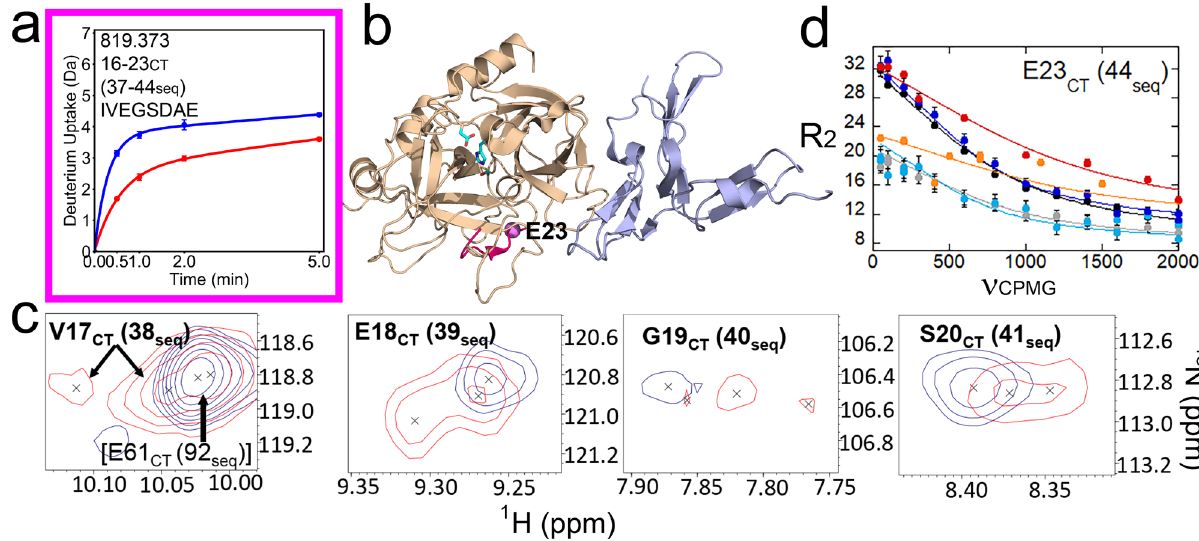
Figure 5. ( a ) Deuterium uptake plot for the peptide spanning residues 16-23 CT (37-44seq; MH + 819.373). ( b ) Location of residues 16-23 CT (37-44 seq ) in the structure of thrombin (wheat) bound to TM456 (light blue) [PDB ID: 1DX5]. (hot pink). The resonance corresponding to Glu 23 CT (44seq) experienced similar μs-ms dynamics in thrombin-TM456 and apo-thrombin (purple sphere). ( c ) Examples of thrombin-TM456 HSQC (red) doublet resonances compared to apo-thrombin (blue) resonances for residues at the N-terminus of the heavy chain. ( d ) CPMG plot for the resonance corresponding to residue Glu 23 CT (44seq) (symbols as in Fig.